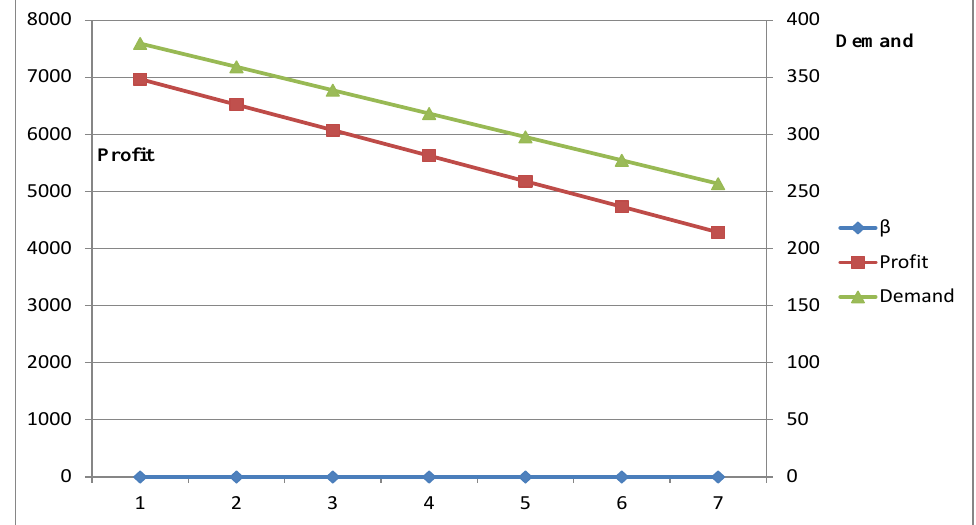
Figure 3. Profit vs. demand with respect to β